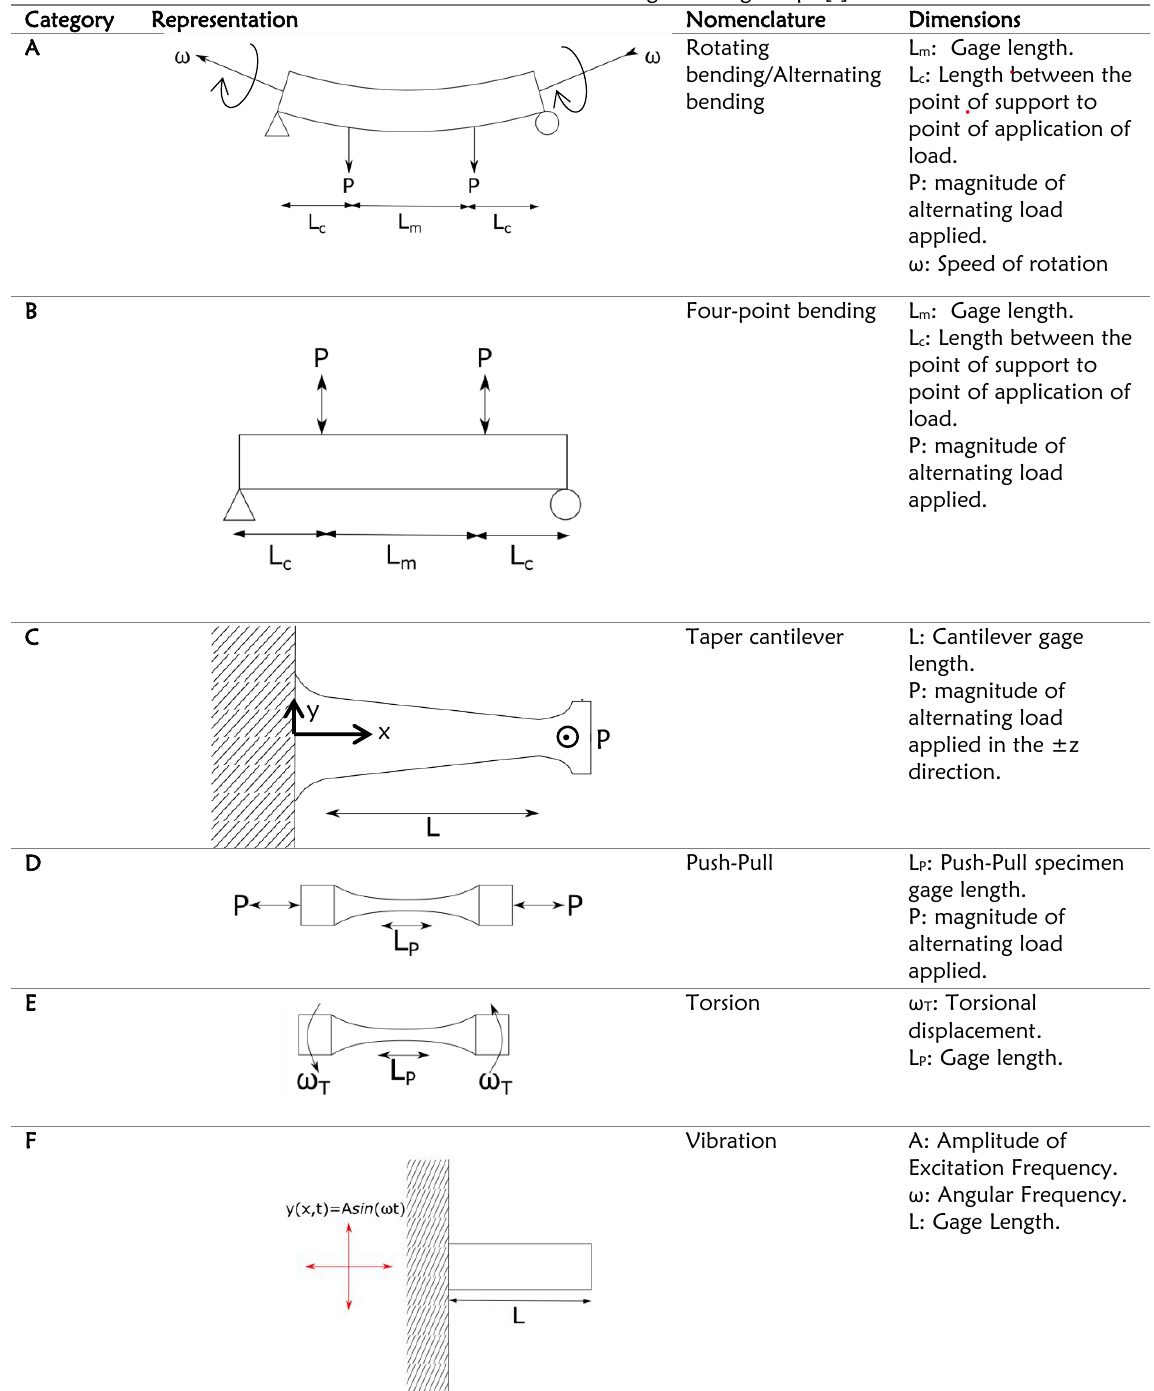
Table 1. Schematics of different fatigue testing setups